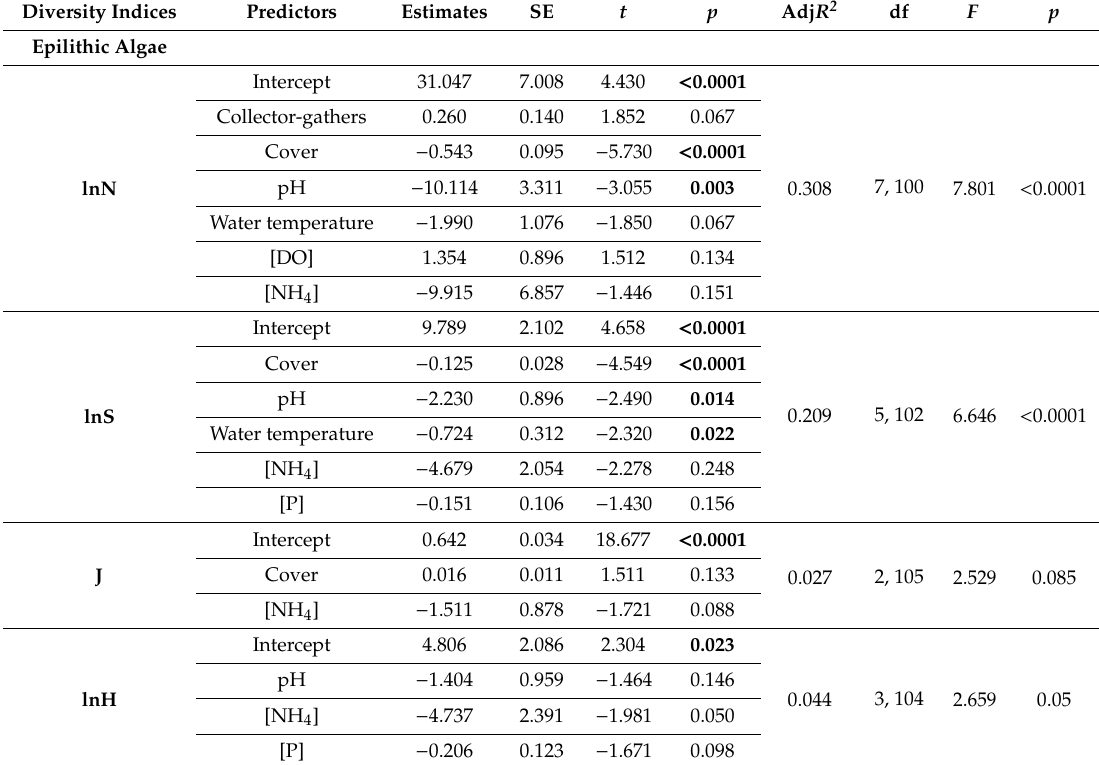
Table 3. Multiple linear regression analyses (summary lm R function) for epilithic algae biodiversity indices. The table shows estimates ± standard error (SE) t -statistics, adjusted R-squared values (Adj R 2 ) and respective p -values for regression coe ffi cients, indicating whether the value of the coe ffi cient is significantly di ff erent from zero ( α = 0.05). Significant di ff erences are in bold. lnN, lnS, and lnH represent ln(x + 1) transformed biodiversity indices. Cover— Salvinia molesta percentage cover. Diversity Indices Predictors Estimates SE t p Adj R 2 p Epilithic Algae